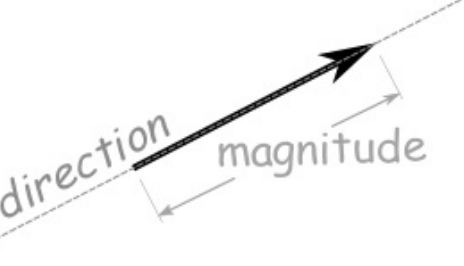
Figure 29. Magnitude and direction of a